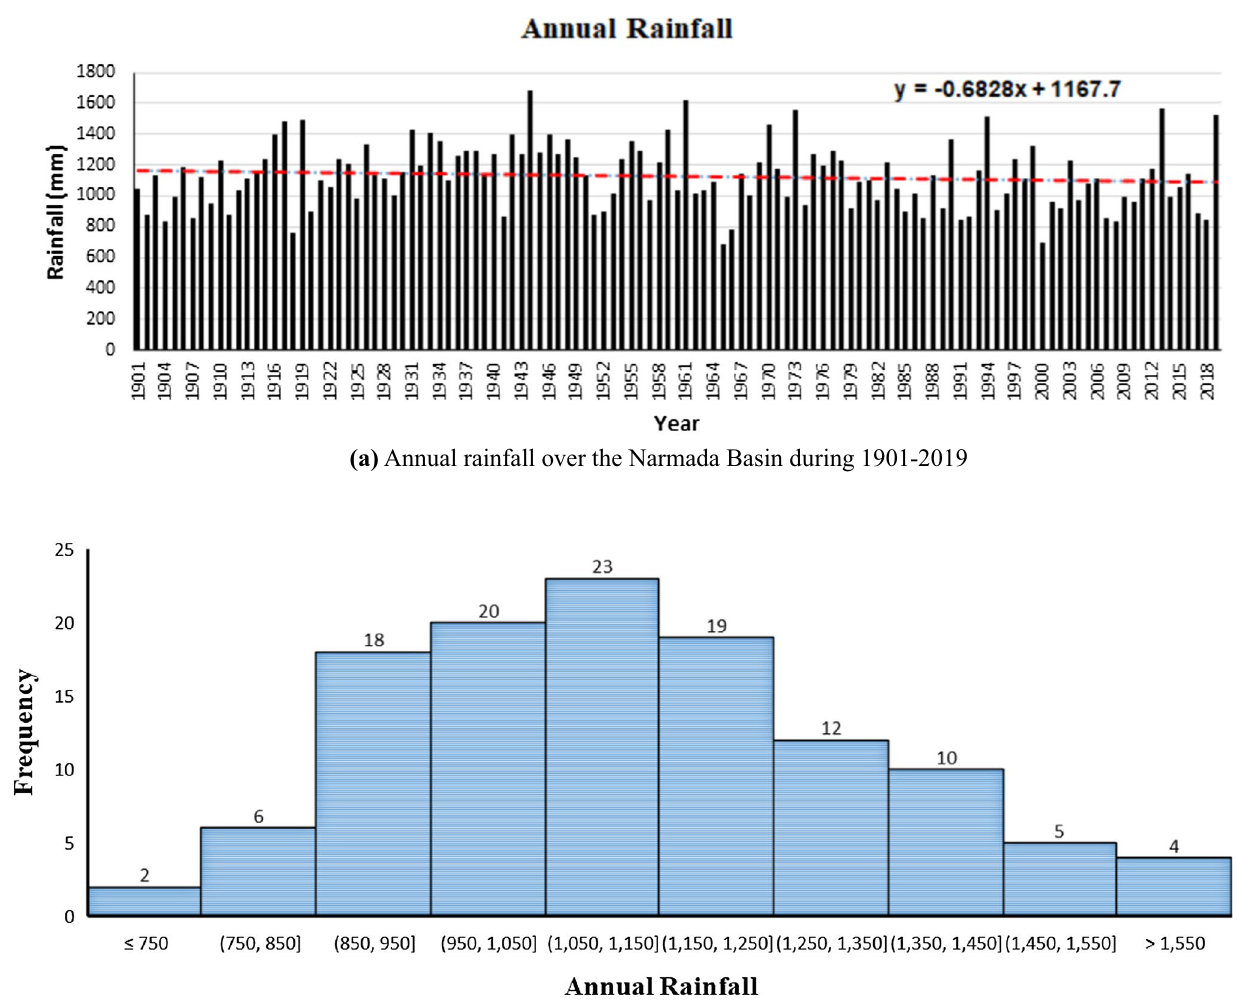
Fig. 3 Time series and frequency distribution of annual rainfall over Narmada Basin during